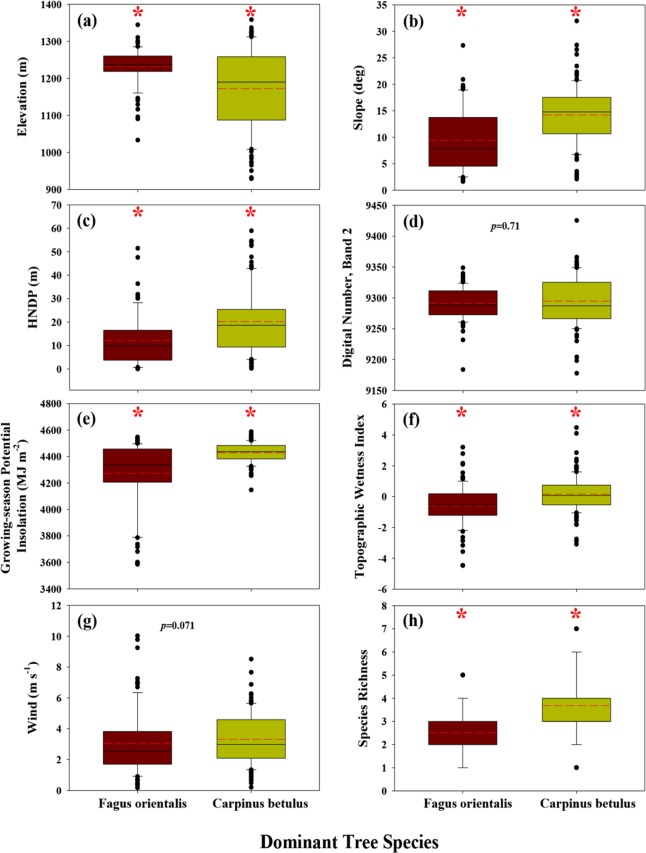
Sampling-plot averages of site and environmental values for Fagus orientalis- and Carpinus betulus-dominated plots.All distributions were statistically different from normal, based on Shapiro-Wilk normality tests and p-values < 0.05. Plots labelled by red asterisks identify statistically-significant differences between medians (based on rank-sum tests and p-values < 0.001) for values associated with Fagus orientalis- and Carpinus betulus-dominated plots.